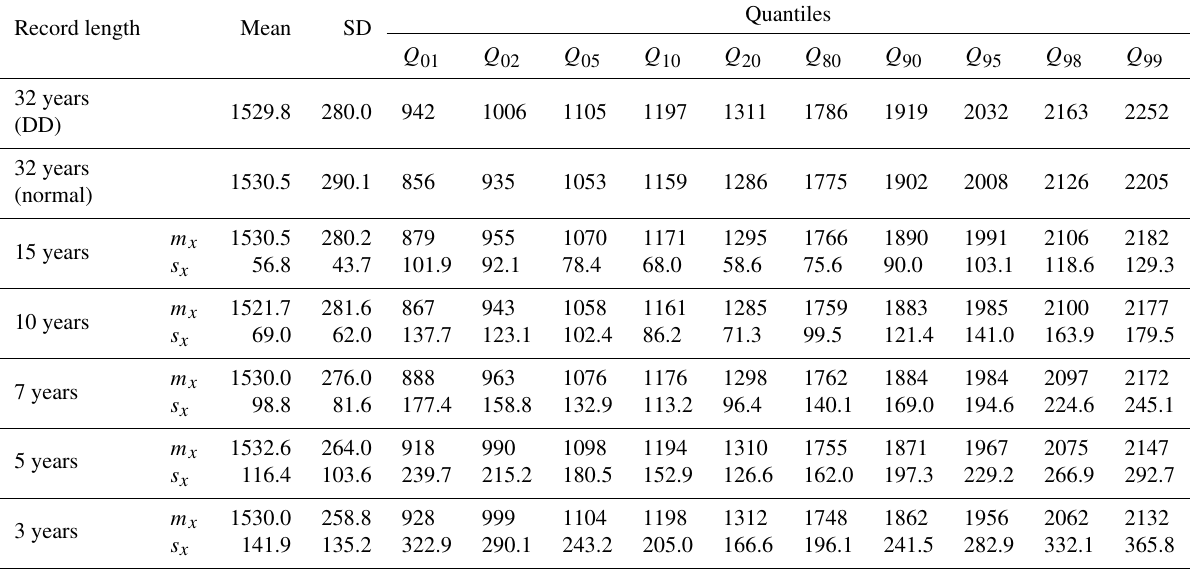
Table A4. Mean, standard deviation (SD), and selected quantiles of the annual rainfall in Lugano (in millimeters), as obtained by fitting normal distributions to the complete 32-year record, and to the same 200 resampled, shorter records as in Table A3 ( m x and s x are the mean and standard deviation of each statistic; note that the results with the DD approach, for the complete record, are given in the first row for